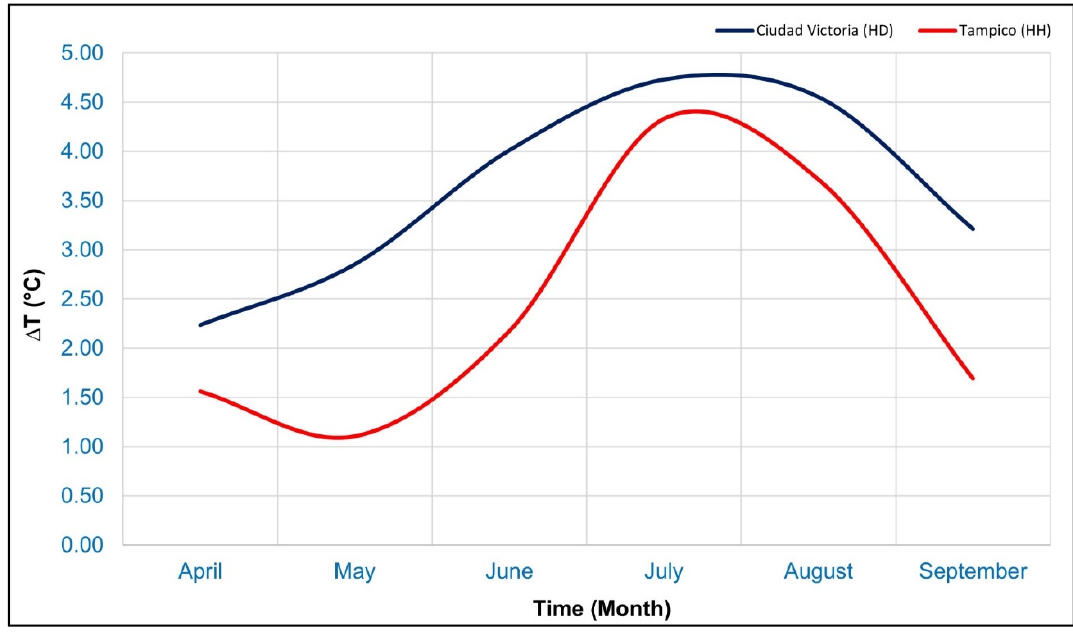
Figure 7. Thermal comfort requirement in a hot dry climate location.